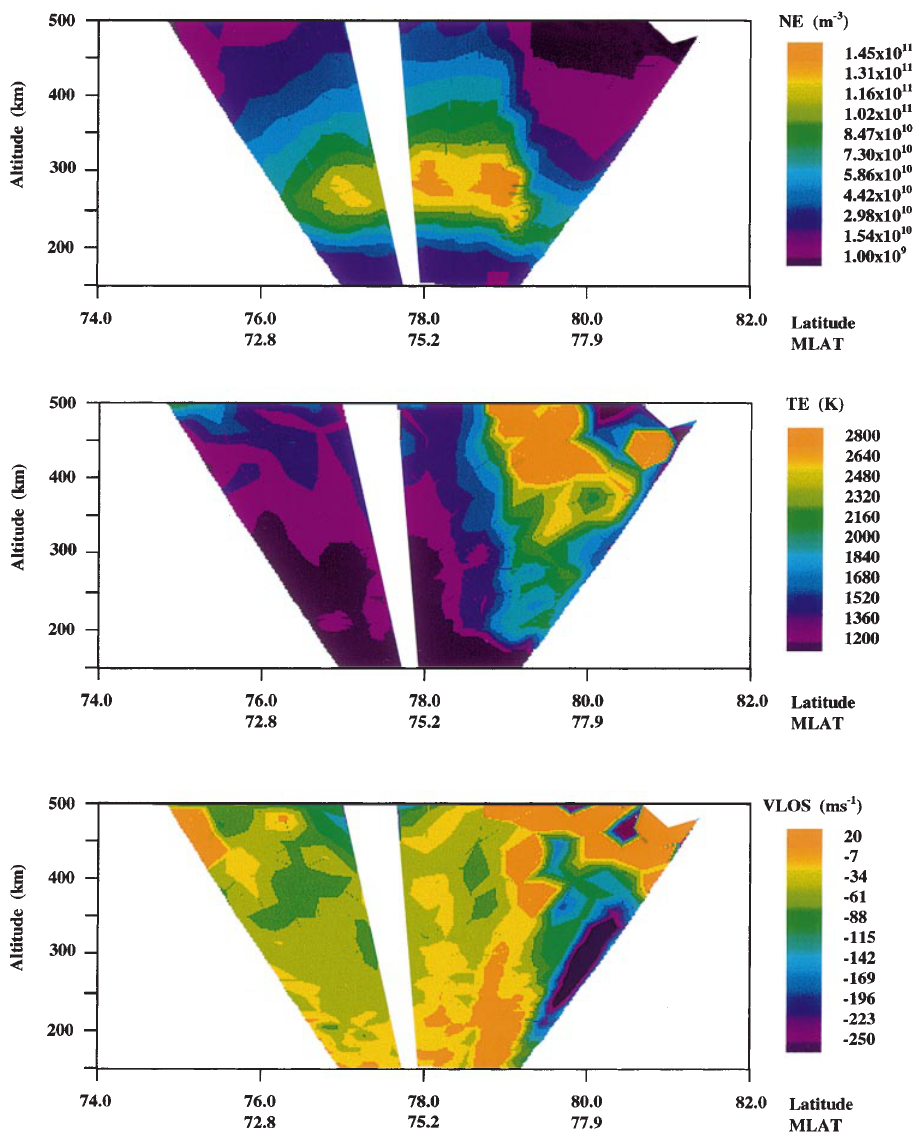
Fig. 7. Electron densities, elec- tron temperatures and line-of- sight ion drift velocities measured by the ESR radar during a scan in the magnetic meridian starting at 0829 UT. Positive velocity values are away from the radar and